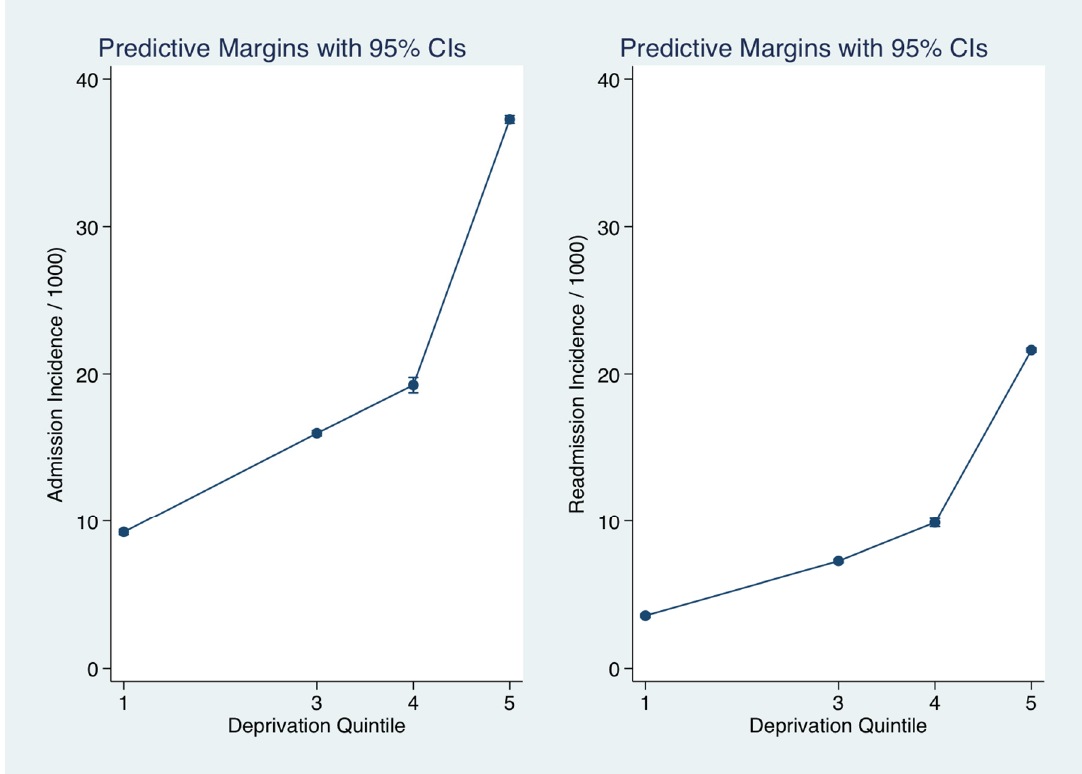
Figure 1. Relationship between Deprivation status and Hospital Admission Incidence rates for emergency medical conditions. The predicted probabilities for each were derived from the zero ‐ truncated Poisson model. We used margins to estimate the average marginal effect. Graphed is Admission Rates/1000 local area population between 2002–2016 for the first or any subsequent admission.